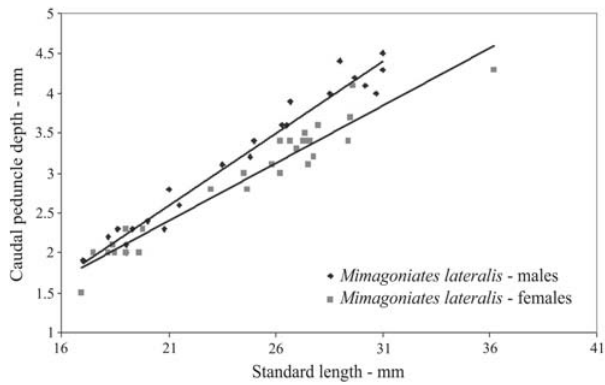
Fig. 62. Mimagoniates lateralis . Caudal peduncle depth as function of SL by